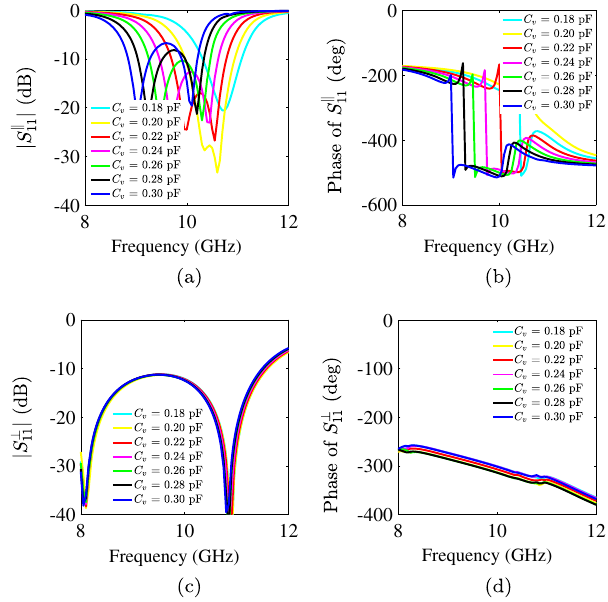
FIG. 22. Simulated reflection coefficient entries for the bire- fringent board. (a) Amplitude and (b) phase of the reflection coefficients for the parallel polarization. (c) Amplitude and (d) phase of the reflection coefficients for the perpendicular polarization.